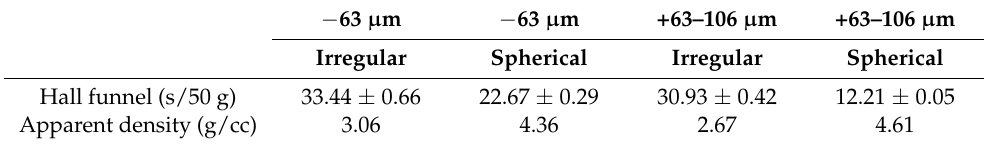
Table 6. Summary of AISI 304 SS flowability